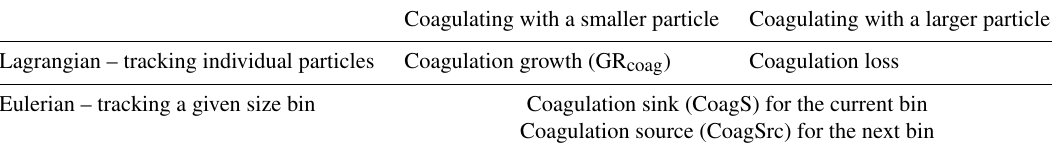
Table 1. The impacts of coagulation characterized in the Lagrangian and Eulerian specifications. Coagulating with a smaller particle Coagulating with a larger particle Lagrangian – tracking individual particles Coagulation growth (GR coag ) Coagulation loss Eulerian – tracking a given size bin Coagulation sink (CoagS) for the current bin Coagulation source (CoagSrc) for the next